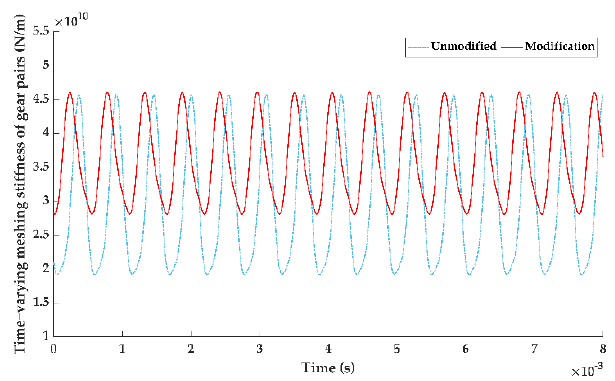
Figure 19. TVMS curve at a load of 400 N·m.